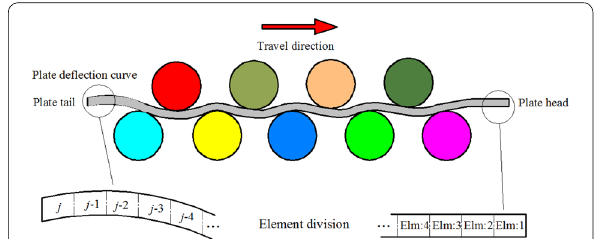
Figure 1 Plate deflection curve